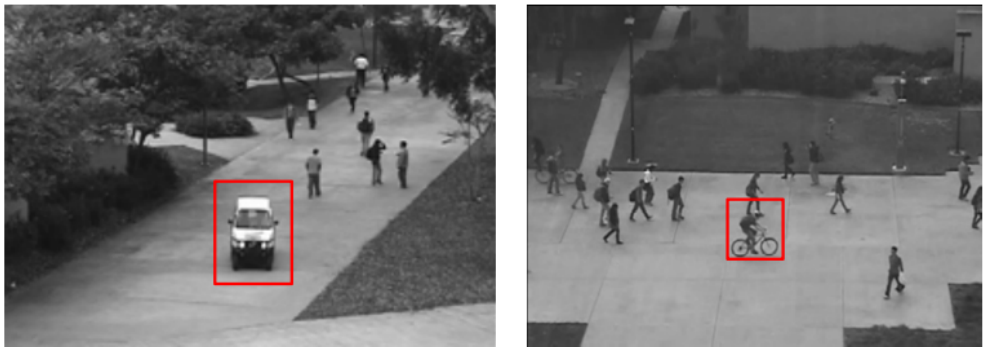
Figure 4. Sample from the UCSD 1 ( left ) and the UCSD 2 ( right ) data set. The red rectangle highlights an anomaly in the form of a small vehicle and a cyclist,